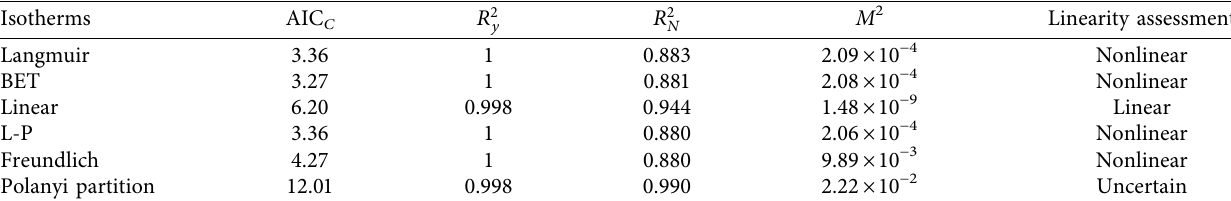
Figure 5: Plot of fitted isotherm (BET) for atenolol adsorption by Table 5: Summary of selected diagnostics for atenolol adsorbed by M-MWCNT.